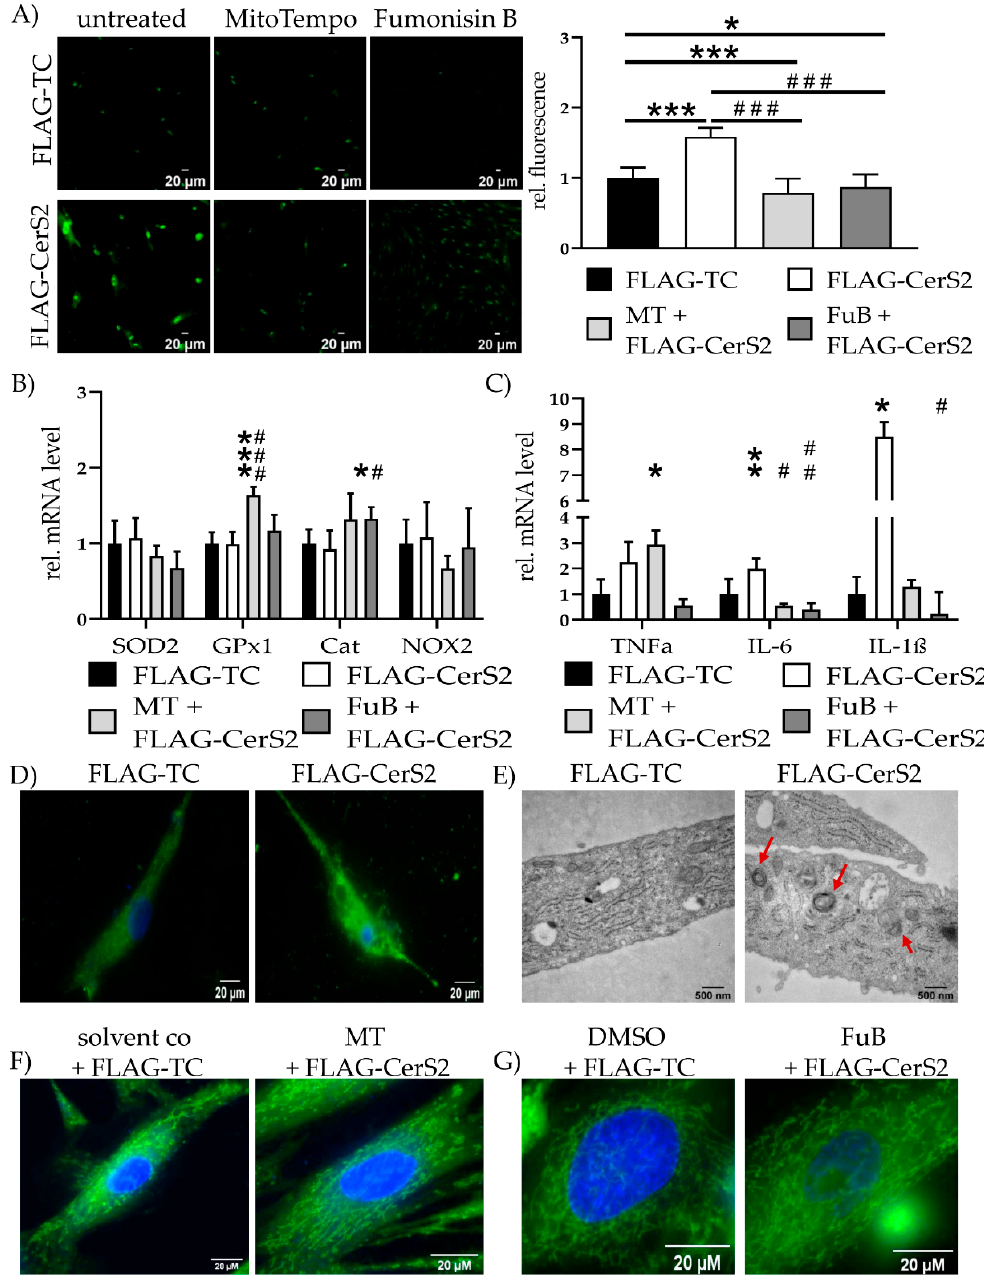
Figure 8. Mitochondrial Homeostasis—Inflammation and structure in FLAG-CerS2. ( A ) Mitochondrial ROS production was visualized with MitoSOX (green) and measured with cLSM. Pictures depict six representative images of three independent measurements. ( B ) mRNA expression levels of ROS scavenger ( SOD2, GPx1, Cat ) and inducer ( NOX2 ). ( C ) mRNA expression levels of inflammatory cytokines ( TNF α , IL-6, IL-1 β ). ( D ) Mitochondrial structure visualized with MitoTracker (green) and cLSM. Nucleus was stained blue. ( E ) Electron microscopies of cells of the FLAG-TC or FLAG-CerS2 condition at 20,000× magnification. Red arrows indicate multilamellar bodies. ( F ) Cells were pre-treated with MT and subsequently transfected. Mitochondrial structure visualized with MitoTracker (green) and cLSM. Nucleus was stained blue. Pre-treatment shows improved mitochondrial structure. ( G ) Cells were pre-treated with FuB and subsequently transfected. Mitochondrial structure visualized with MitoTracker (green) and cLSM. Nucleus was stained blue. Pre-treatment with FuB restored some of the physiological net-like mitochondrial structure. Depicted are mean values and standard deviation of minimum three biological replicates. Significances were calculated with a t -test. * = significant to FLAG-TC. # = significant to FLAG-CerS2. (*/# p ≤ 0.05, **/## p ≤ 0.01, ***/### p ≤ 0.001).